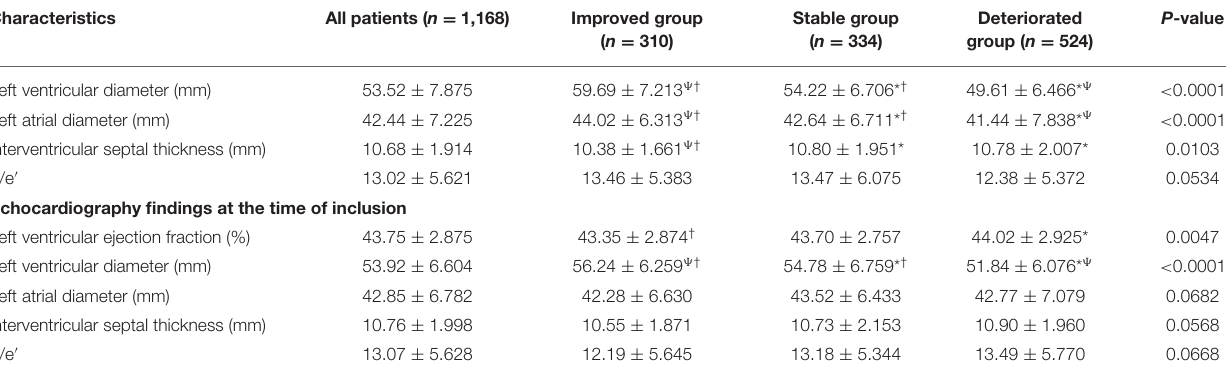
composite outcome (HR: 1.324, 95% CI: 1.020–1.718, P =